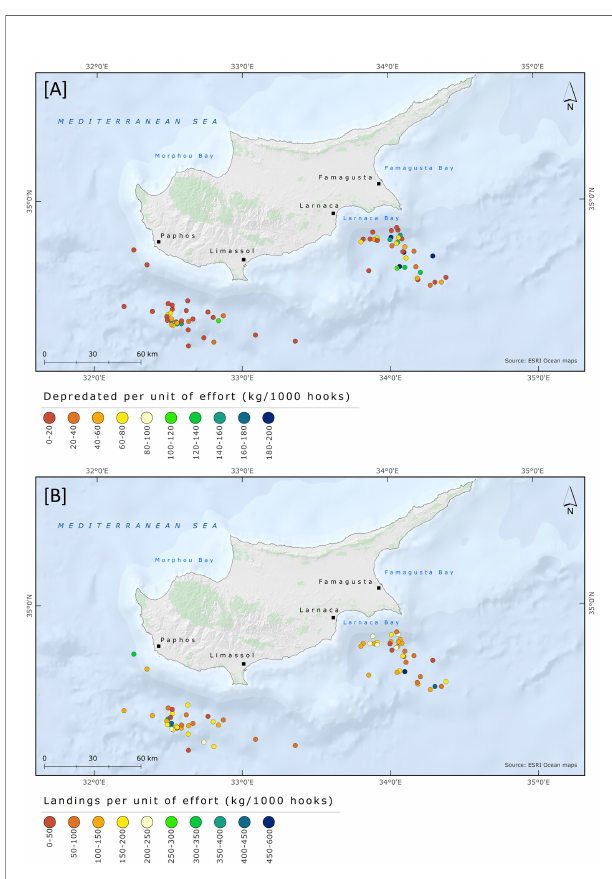
FIGURE 7 | Spatial distribution of pelagic longline fi shing trips targeting albacore tuna between June and August 2018 with information regarding (A) depredation events and (B) Depredation rate (%).